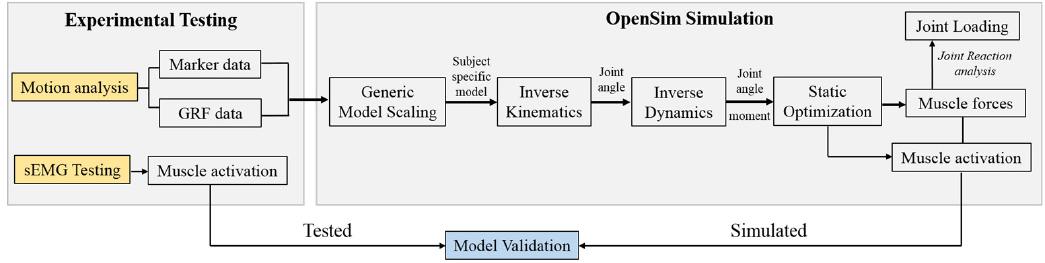
Figure 1. Data processing flow chart, from experimental testing to OpenSim simulation. Note. GRF: ground reaction force; sEMG: surface electromyography.